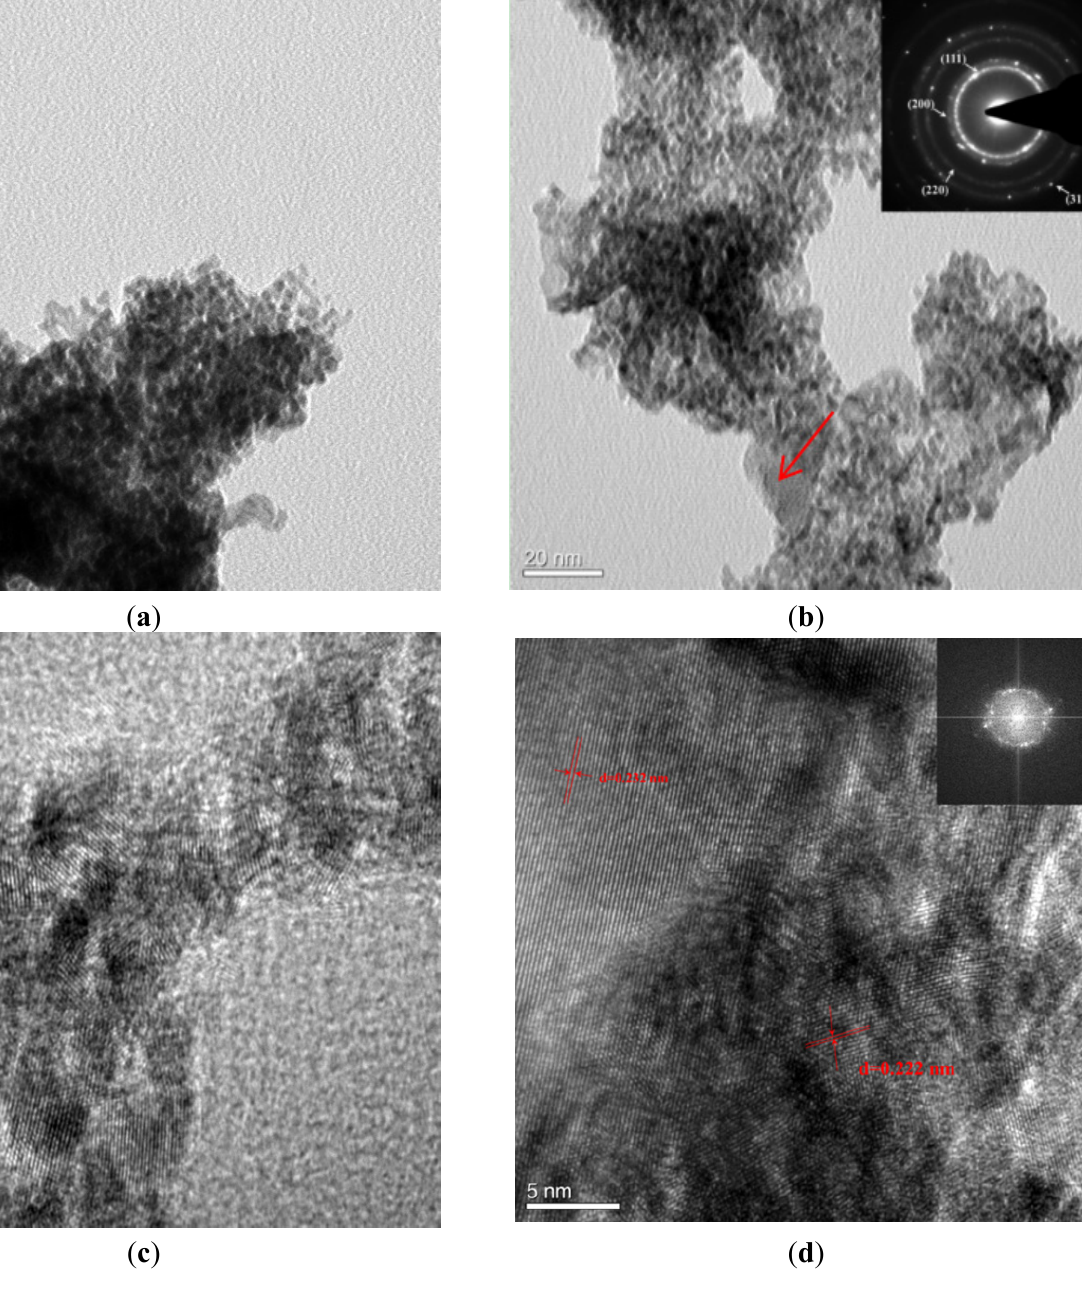
Figure 2. ( a , b ) TEM and ( c , d ) HRTEM images of the np-PtRuCuW alloy with nanoporous microstructure; Insets in ( b , d ): typical SAED and FFT spectrums,